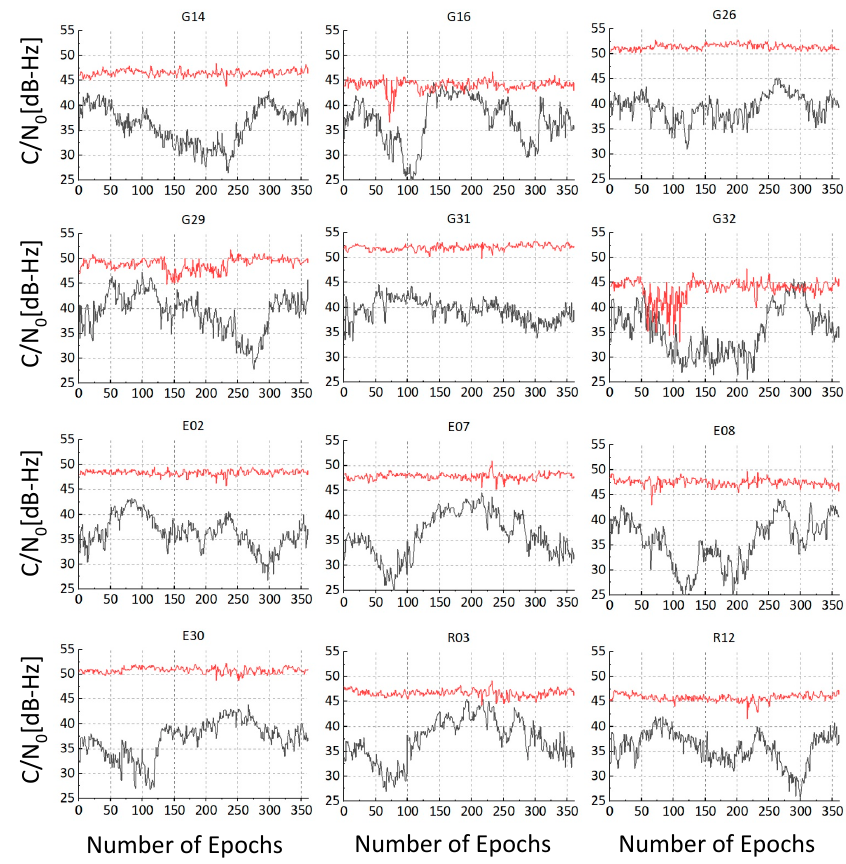
Sensors 2019 , 19 , x FOR PEER REVIEW Figure 9. C/ N 0 of GPS, Galileo and GLONASS satellites (Receiver: red lines; Smartphone: black lines). Table 6. Mean and standard deviation of 𝐶/𝑁 (cid:2868) of GPS, Galileo and GLONASS [dB-Hz].